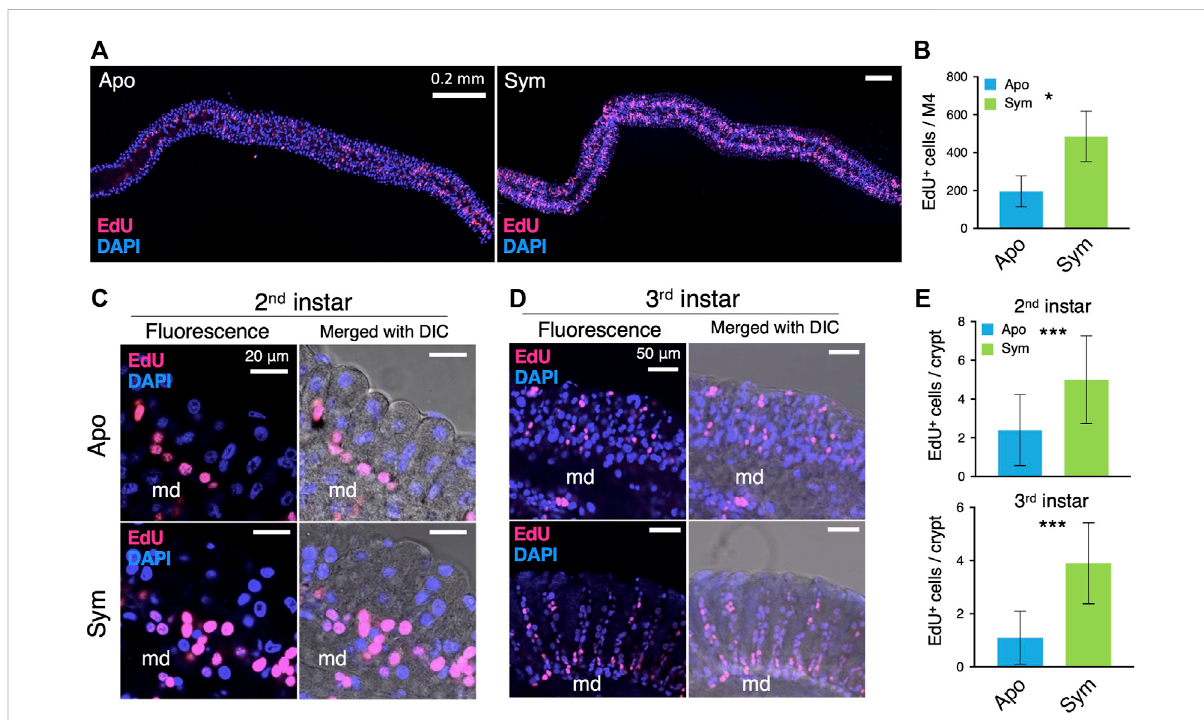
FIGURE 2 Caballeronia symbionts stimulate the proliferation of ISCs. ISCs are visualized by EdU staining (red) and compared between aposymbiotic and symbiotic insects. Blue fl uorescence corresponds to host nuclei stained with DAPI. (A) Wholemount images of the symbiotic organ. (B) The number of EdU-positive (EdU + ) cells per symbiotic organ ( n = 3). LSM images of midgut crypts in (C) second instar and (D) third instar. Merged images of fl uorescence and DIC are also shown to visualize crypts and the main duct (md). Note that EdU + cells (i.e. proliferating ISCs) are densely localized at the base part of crypts, which is obvious in symbiotic insects. (E) The number of EdU + cells per crypt ( n = 9) was statistically analyzed by the Mann-Whitney U test (*, p < 0.05; ***, p < 0.001). Apo, aposymbiotic; Sym, symbiotic